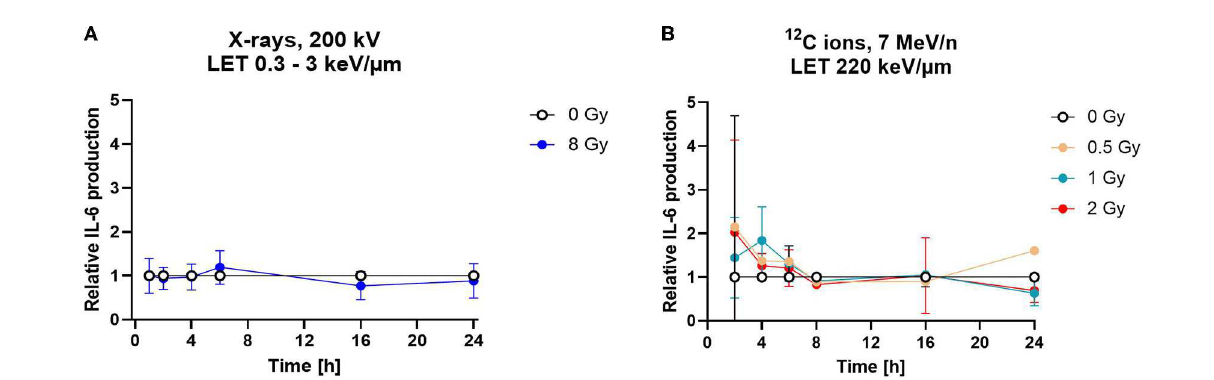
FIGURE10 Astrocytes secrete the cytokine interleukin-6 independently of radiation exposure. Secretion of cytokine IL-6 was measured by ELISA. (A) The relative IL-6 concentration of in cell culture media supernatants is displayed for astrocytes irradiated with 8Gy of X-rays over a time course of 1–24h. The samples were compared via 2way-ANOVA (not significant, n = 5). (B) Astrocytes exposed to different doses of 12 C ions (LET 220 keV/ µ m, 7 MeV/n) did not secrete more IL-6 than the mock-irradiated controls (0Gy) for all conditions tested. The samples were compared by two-way-ANOVA (not significant, n = 4). Relative IL-6 concentrations were obtained by normalization of the absolute IL-6 concentration in the supernatants of the irradiated samples to the concentration in the supernatant of the mock-irradiated control (0Gy) at each time point. Data are shown as mean ± SD for (A, B) . In case that the error bars are smaller than the symbol, they are not visible (A, B) .